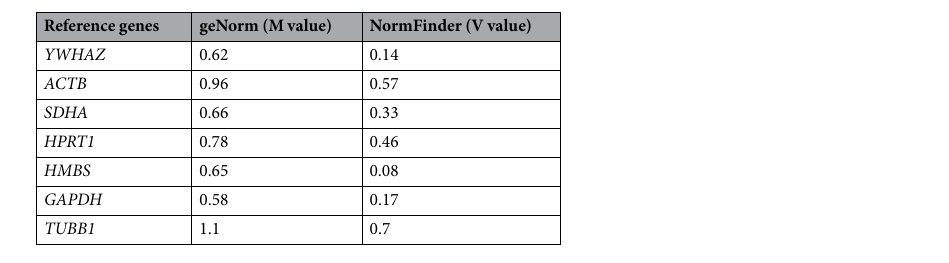
Table 4. Stability value of seven candidate reference genes based on result from geNorm and NormFinder. Results from three biological replicates (n = 3). One biological replicate of each sample consisted of IEL-28.4 + cells harvested from 8 chickens.